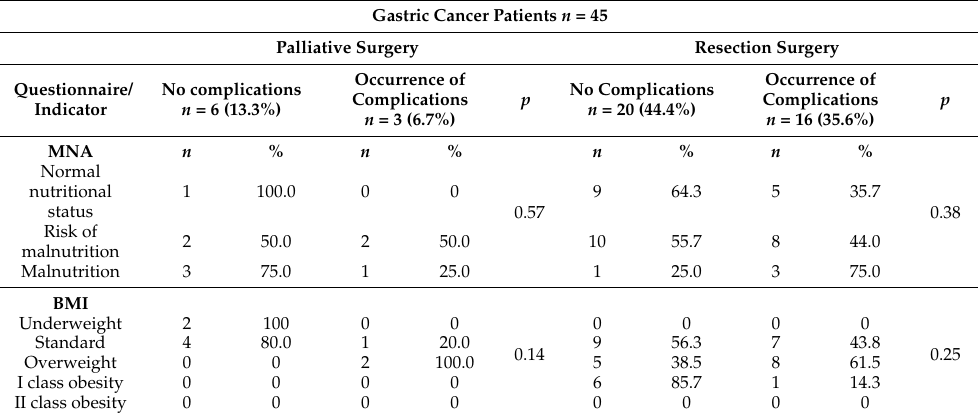
Table 2. The nutritional status of patients with gastric cancer before surgery and the incidence of postoperative complications considering the type of surgery.